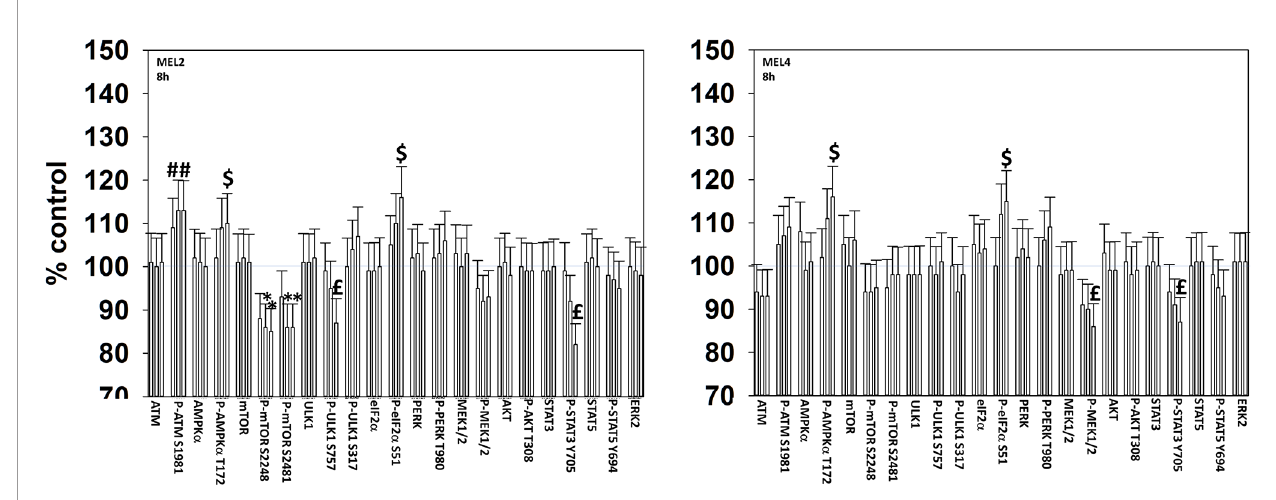
FIGURE 5 | Exposure to [GZ17-6.02 + trametinib + dabrafenib] maintains elevated endoplasmic reticulum stress signaling and inactivation of STAT transcription factors. Melanoma cells were treated with vehicle control, GZ17-6.02 [curcumin (2 µM) + isovanillin (37.2 µM) + harmine (4.5 µM)], [trametinib (2 µM) + dabrafenib (2 µM)] or the drugs in combination for 8h. (the three bars per protein from left to right are trametinib/dabrafenib, GZ17-6.02 and the drugs combined). Cells were fi xed in place and in-cell immunostaining performed to determine the expression and the phosphorylation of the indicated proteins (n = 3 +/-SD) *p < 0.05 less than vehicle control; £ p < 0.05 less than either drug as a single agent; # p < 0.05 greater than vehicle control; $ p < 0.05 greater than either drug as a single